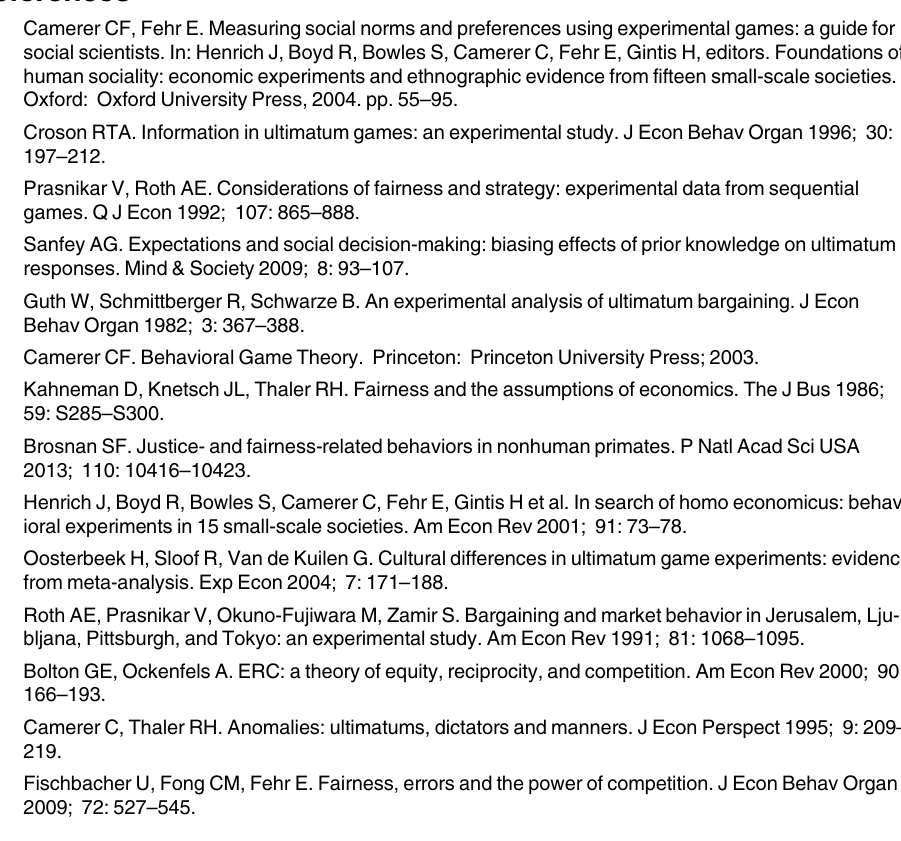
S12 Fig. PRISMA Flow Diagram for Meta-analysis of Existing Ultimatum Game